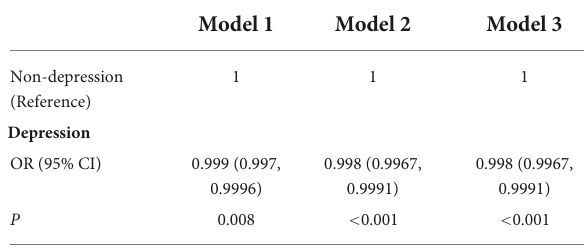
TABLE 3 Association between caffeine intake and depression (logistic regression model).